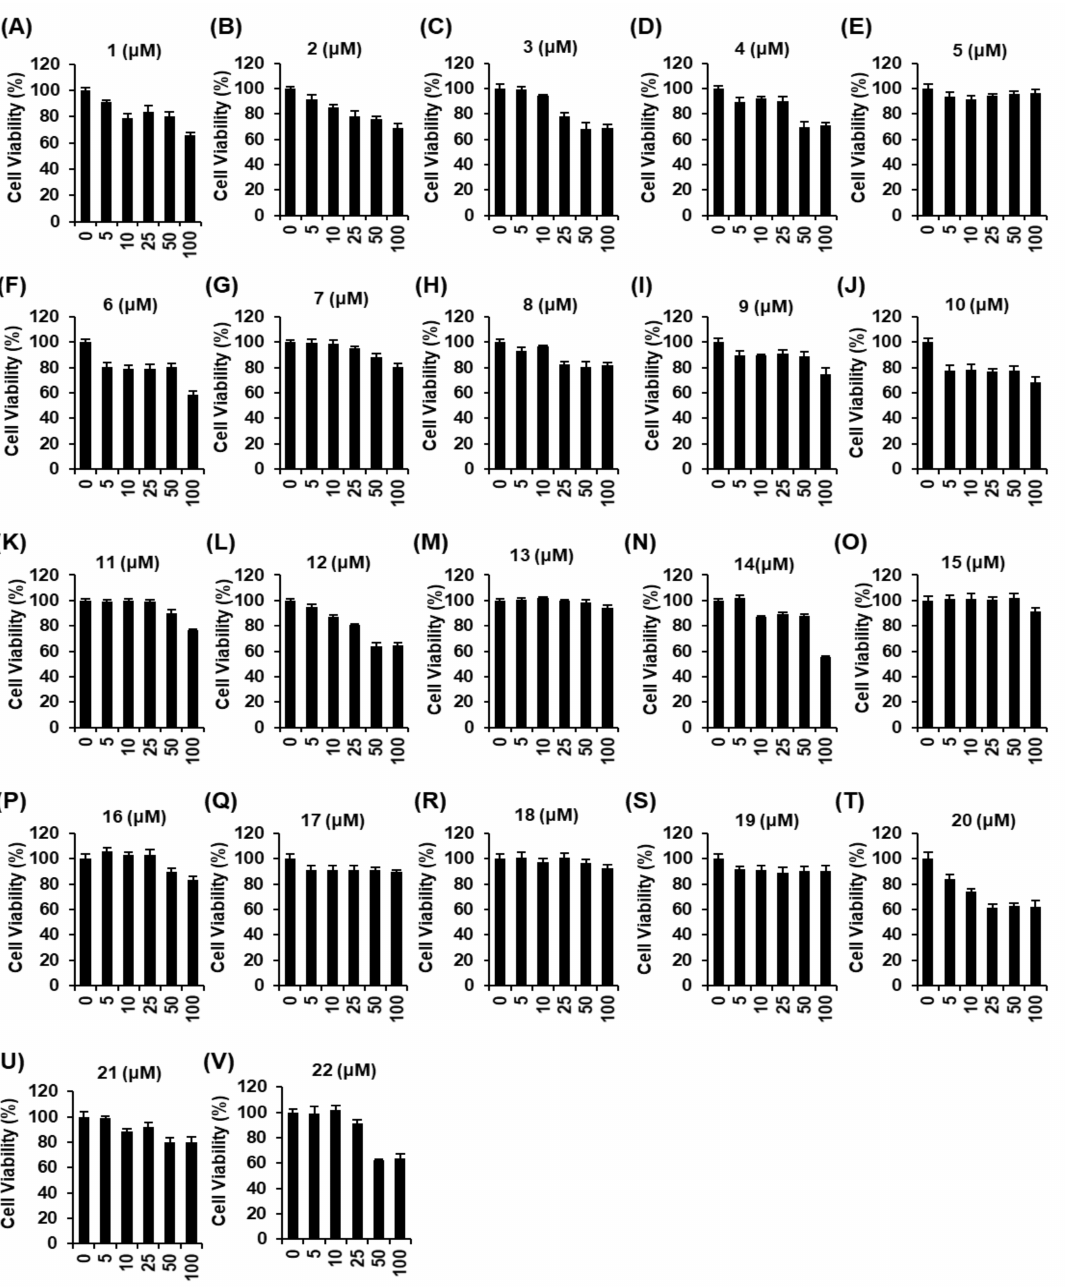
Figure 2. Effects of compounds 1–22 isolated from M. alba fruits on the viability of RAW 264.7 mouse macrophages. Effect of ( A – V ) compounds 1 – 22 , compared with the control (0 µ M), on the viability of RAW 264.7 mouse macrophages for 24 h by MTT